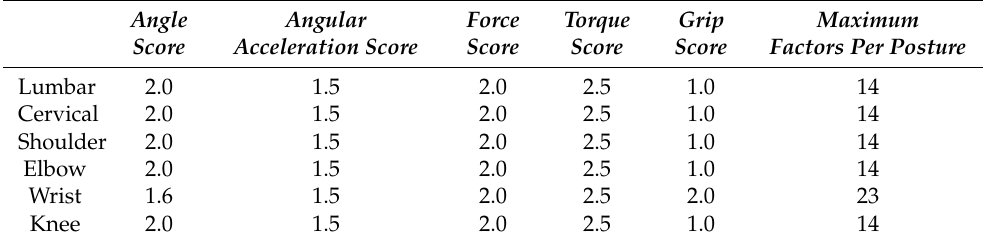
Table 4. MaximumFactorPerPosture for each